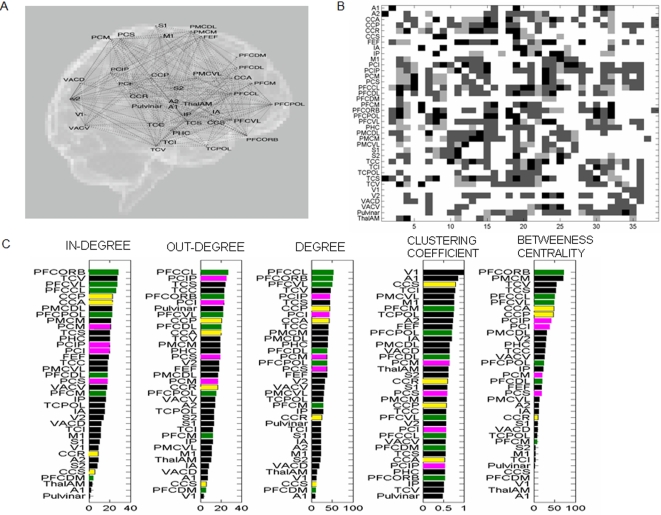
Anatomical connectivity.(A) The primate cortical connectivity map is overlaid over the human cortical locations. See Table 1 for abbreviations. (B) The connectivity matrix of primate cortical graph (white pixel implies no connection; grey scale indicates the weight of the connection). The columns are sources and rows are targets. (C) Statistical characterization of the primate connectivity matrix: node wise degree distributions, clustering index and betweeness centrality (14). The color codes for areas of interest: green, prefrontal; magenta, parietal; yellow, cingulate; black, all others. The connectivity matrix has characteristic path length = 1.633; clustering index = 0.568.